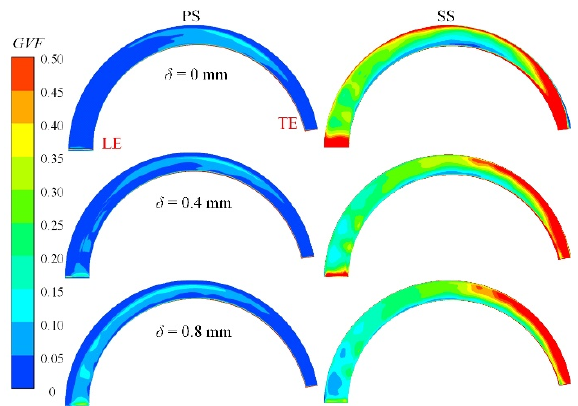
Figure 11. Distributions of gas volume fraction on PS and SS.